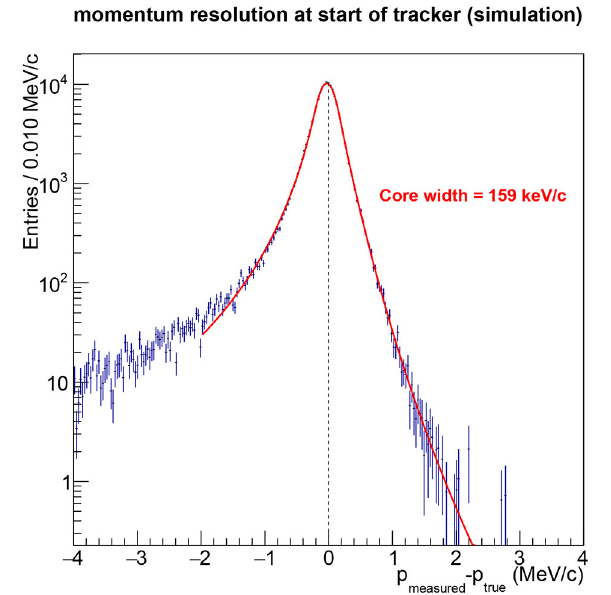
FIGURE 13 | The resolution of the Mu2e tracker for electrons at the conversion energy. The sample is chosen with cuts approximating the final data sample. The asymmetric low side tail is because of the stochastic nature of energy loss in the tracker. Note that the high-side tail, where decay-in-orbit events would be “promoted” to the signal region, is small. The simulation uses measured properties of the tracker, charge cluster formation, processing by the electronics, and passage through simulated DAQ, which is then passed to a reconstruction program that includes accidental activity from the beam and stopped muons. “Core resolution” refers to a fit to the central part of the resolution and can be thought of as the Gaussian σ . Courtesy of the Mu2e